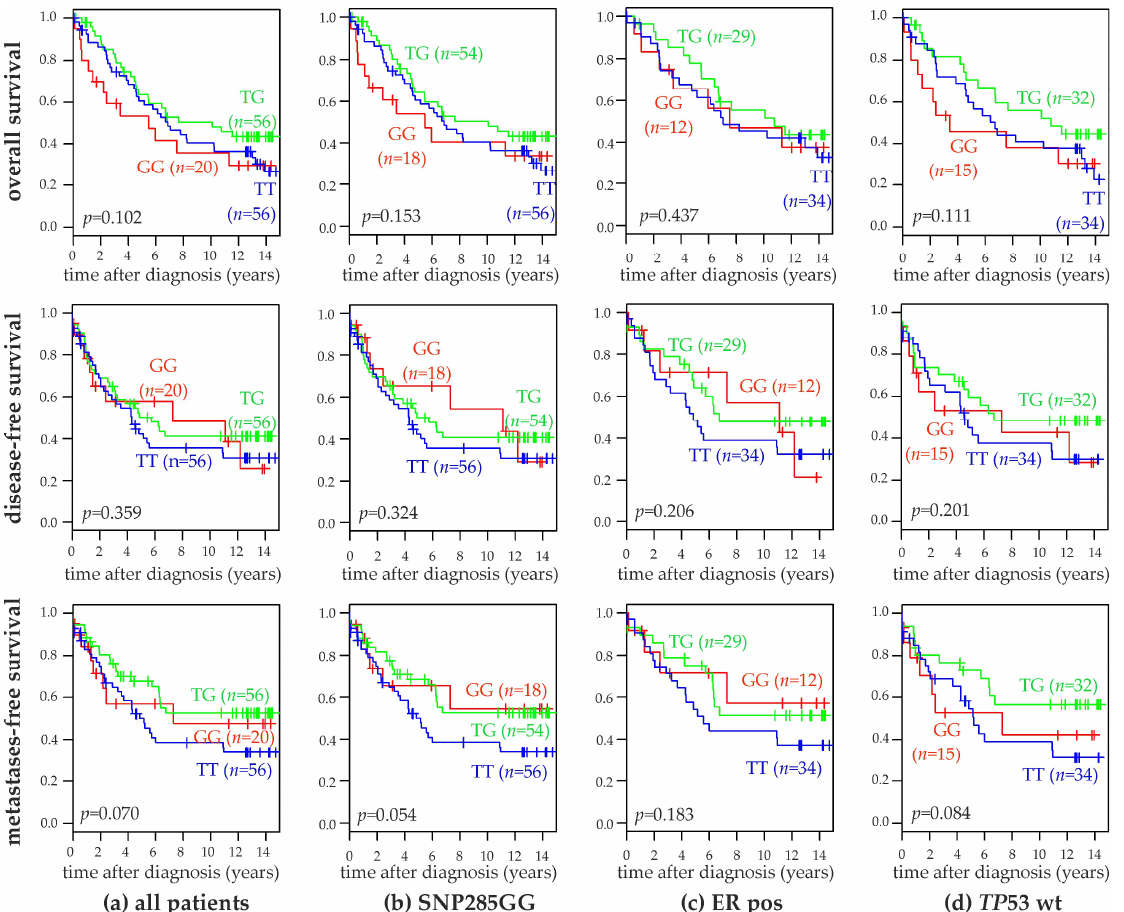
Figure 2. Association of SNP309 genotypes with the survival of human breast cancer patients. Kaplan-Meier analyses of the overall survival (top panels), disease-free survival (middle panels), and metastasis-free survival (bottom panels) in unselected patients ( a ; n = 132), patients with the SNP285 GG-genotype ( b ; n = 128), ER positive patients ( c ; n = 75) and TP53 wildtype patients ( d ; n = 81) are shown. Patient subgroups with SNP309 genotypes TT, TG, and GG as well as their numbers ( n ) are indicated in each panel. ER, estrogen receptor; and wt, wildtype.